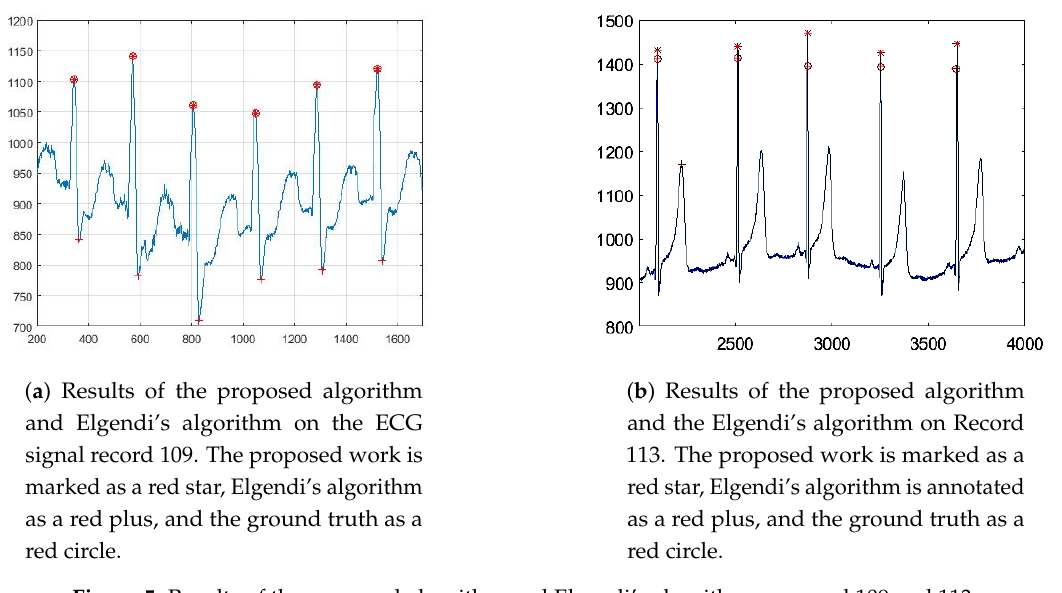
Figure 5. Results of the proposed algorithm and Elgendi’s algorithm on record 109 and